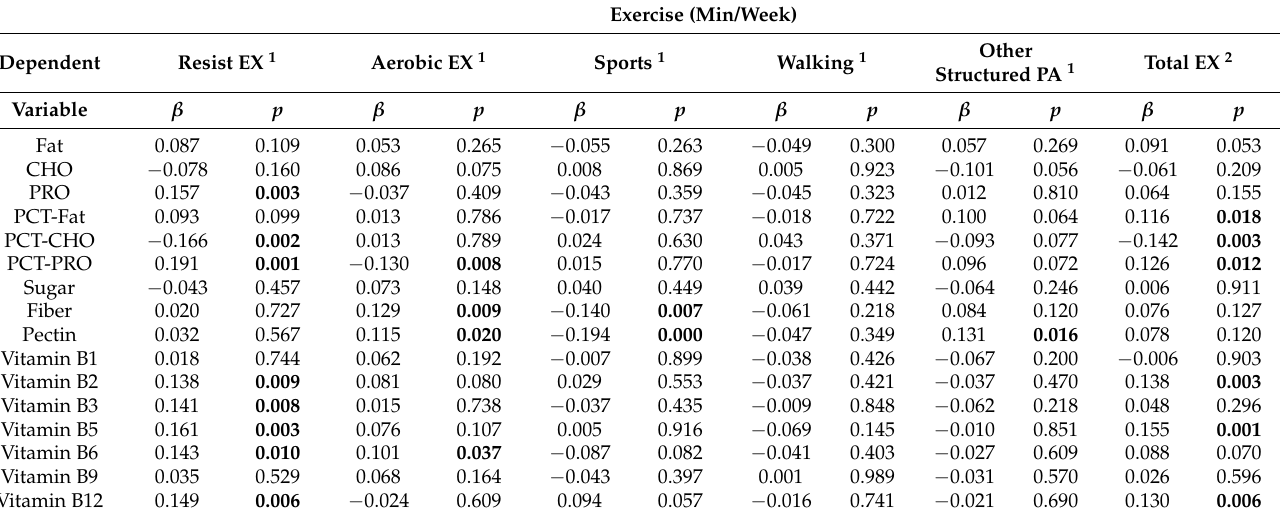
Table 4. The associations between the time of participation in different types of exercise and nutrient intake.